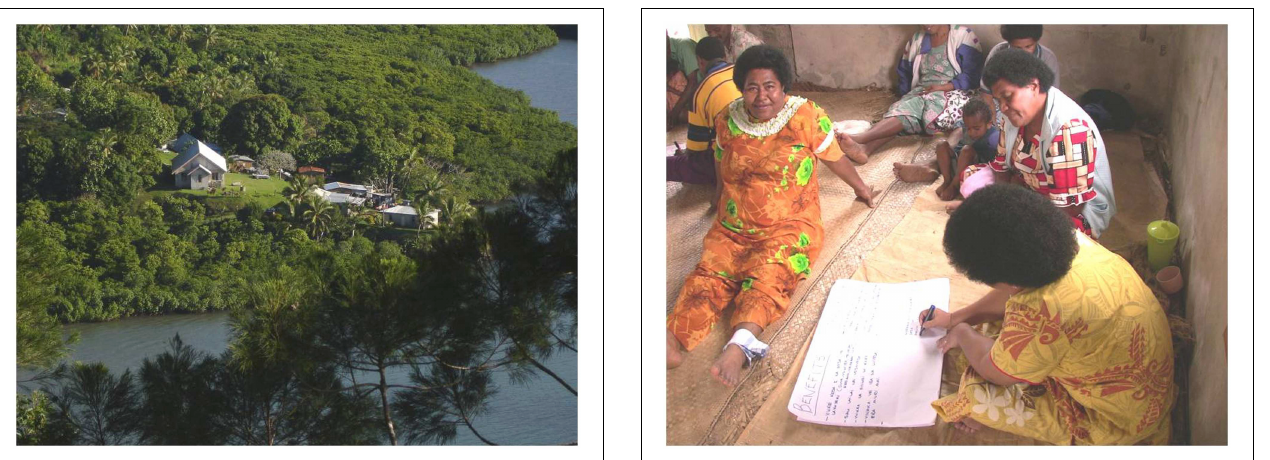
FIGURE 2 | Solodamu village. FIGURE 3 | Solodamu village